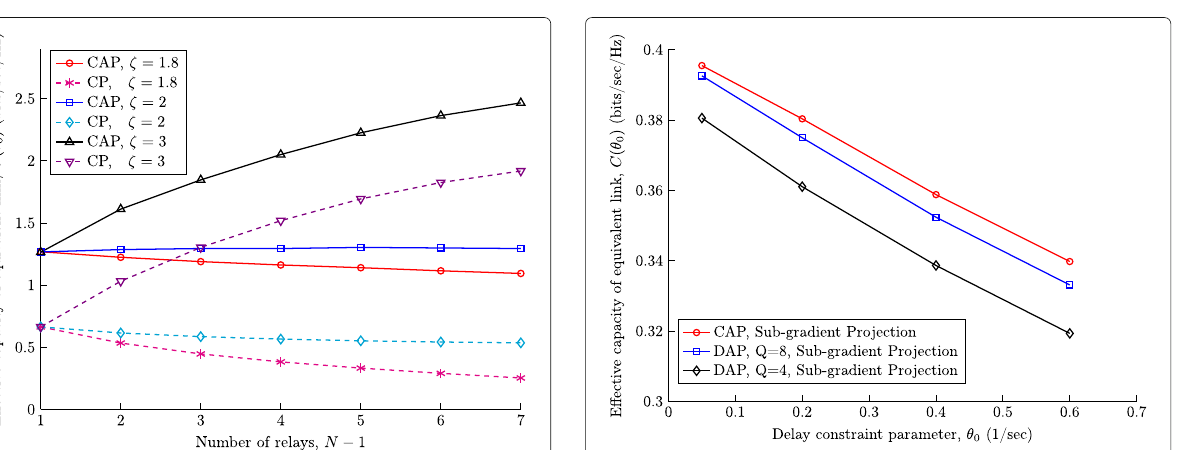
(cid:20) ¯ P N − 1 = 3 W/Hz, θ = 0.1 i 0 i = 0